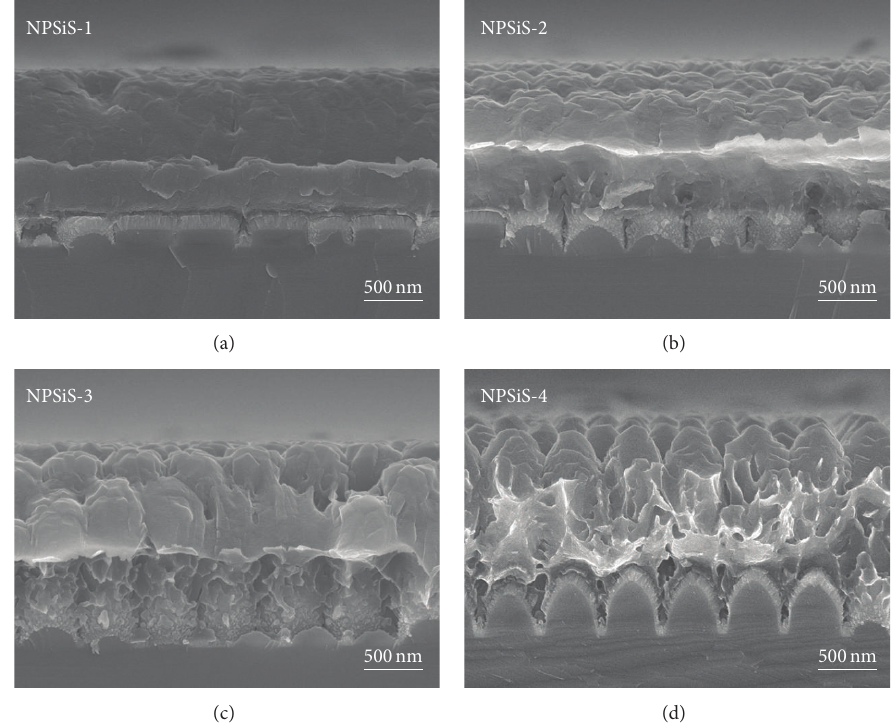
Figure 8: SEM images of metal contacts of four NPSiS HJT cells: (a) NPSiS-1 HJT cell, (b) NPSiS-2 HJT cell, (c) NPSiS-3 HJT cell, and (d) NPSiS-4 HJT